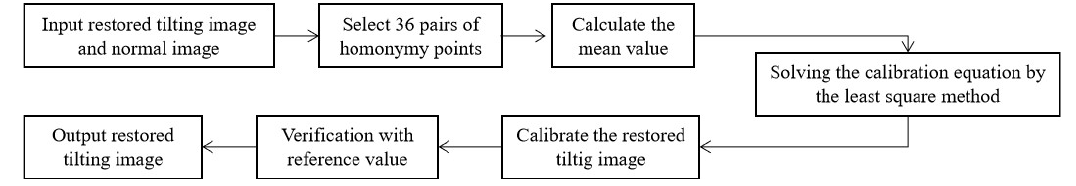
Figure 11. Flow chart of tilting image calibration.